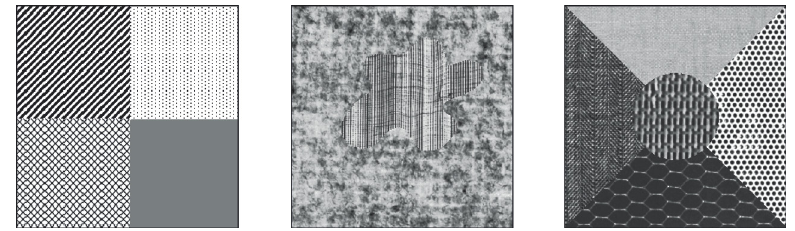
Fig. 8. Test images: Image 1 (Left image), Image 2 (Middle Image), Image 3 (Right Image).